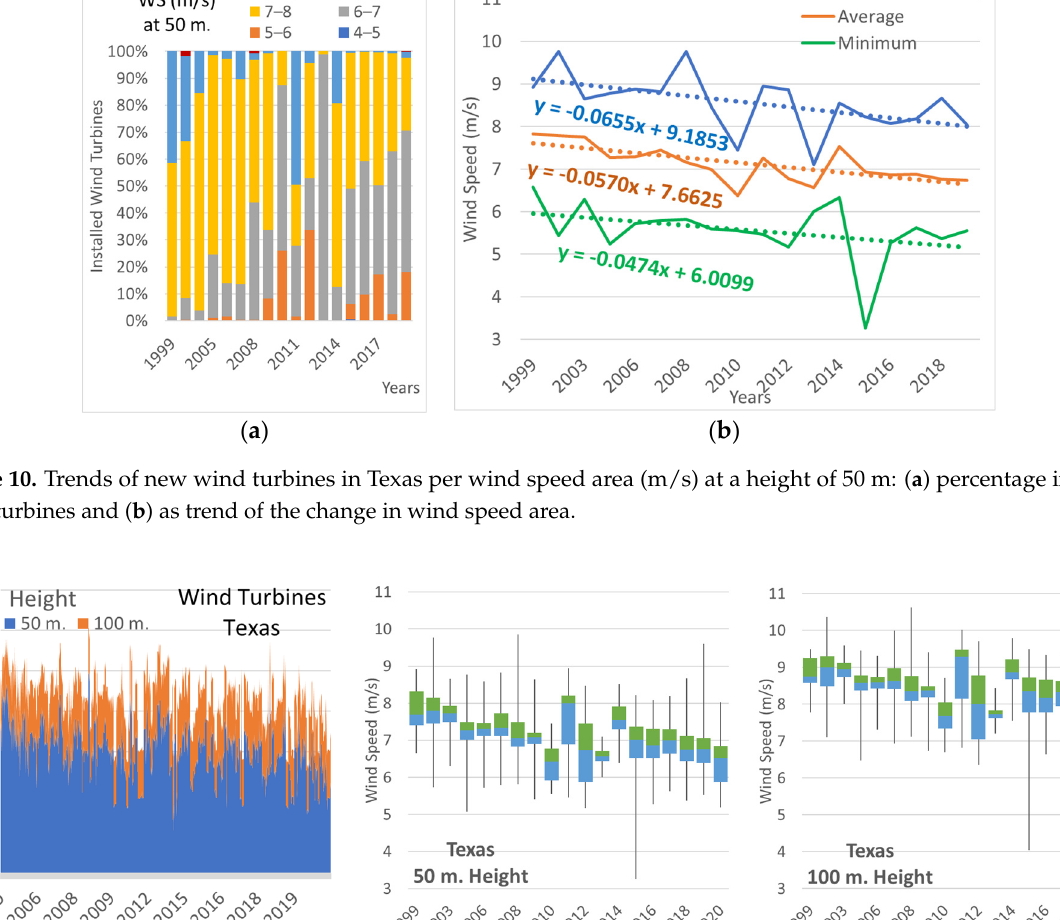
Figure 10. Trends of new wind turbines in Texas per wind speed area (m/s) at a height of 50 m: ( a ) percentage installed wind turbines and ( b ) as trend of the change in wind speed area.